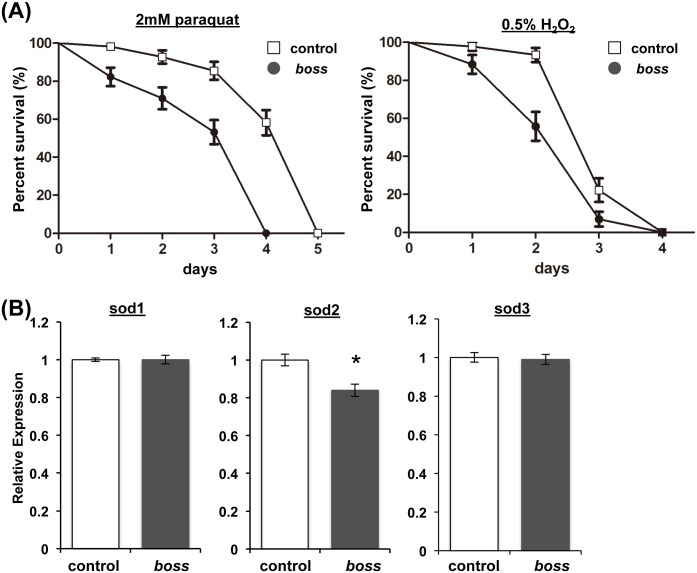
boss mutant flies are sensitive to oxidative stress.(A) Young adult male boss mutant and control flies were fed a diet containing either 2.0 mM paraquat or 0.5% H2O2, and survival rate of the groups was measured (n = 30 flies for each genotypes). Log-rank test, p<0.0001. Error bars represent S.E. (B) Expression of superoxide dismutases (SOD1-3) in young (10-days) flies as measured by qRT-PCR. Data are means ± SEM (t-test, *P<0.05).